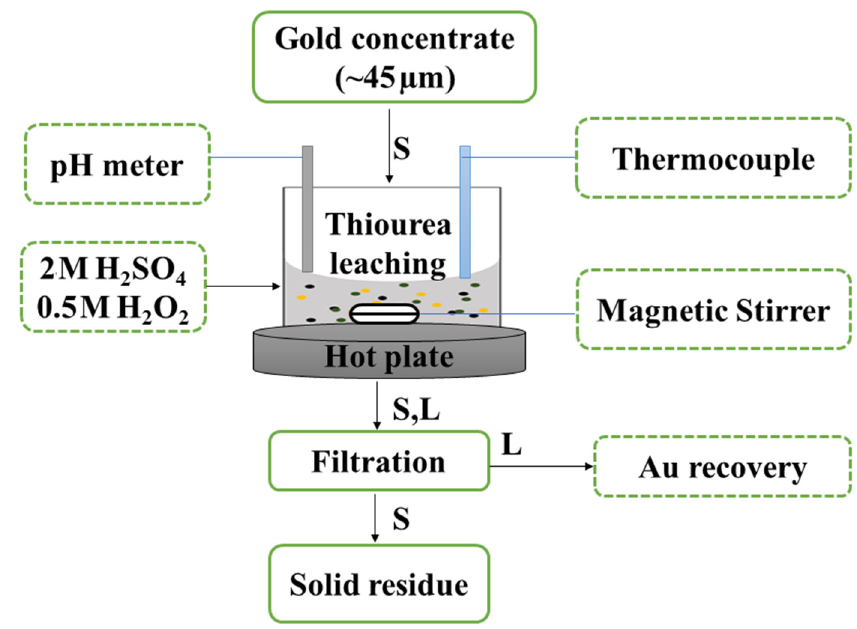
Figure 1. Flowsheet of Thiourea leaching